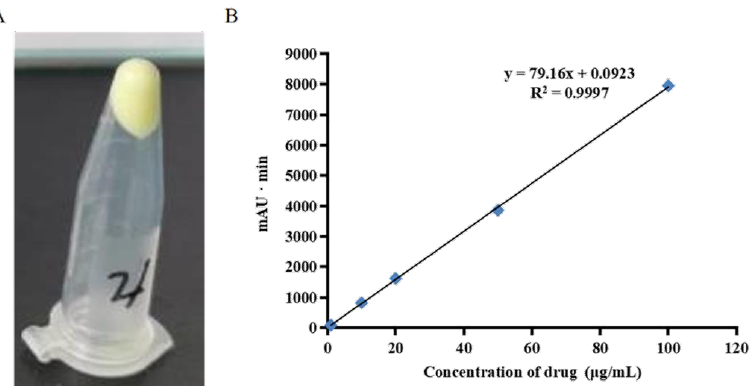
Figure 3. Stability of chrysomycin A cream and HPLC calibration curve of CA. ( A ) No strat-